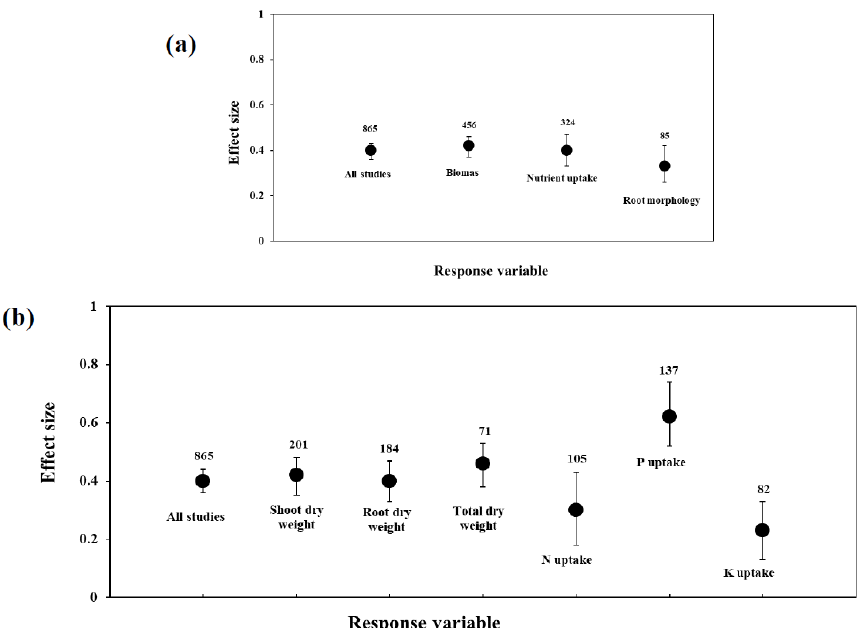
Figure 1. Effect of arbuscular mycorrhizal fungi inoculation responses under drought stress. ( a ) The overall analysis of the dataset. ( b ) Response variables analysis. Error bars are means ± 95% bootstrap confidence intervals (BS CIs). Where the BS CIs do not overlap the horizontal dashed lines, the effect size for a parameter is significant at p < 0.05. All response ratios differed significantly from zero. The numbers of trials are shown above the bar. Table 1. AMF inoculation effect on plant growth and nutrient uptake under drought